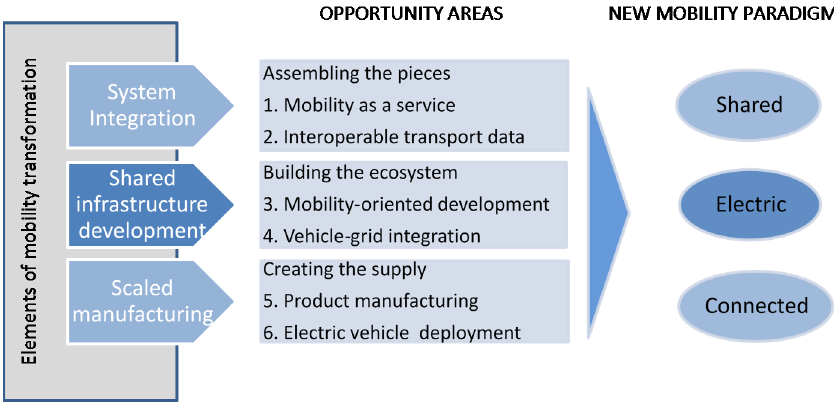
Figure 3. India’s strategy to reduce vehicular emission—A whole system approach to mobility transformation [9].